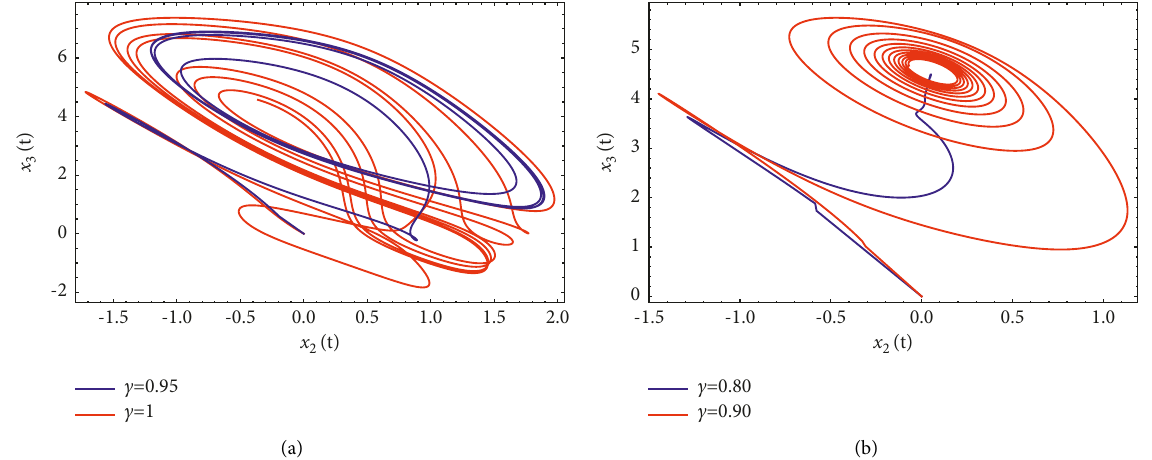
Figure 3: Dynamics of coexisting multiple attractors’ for gradient β (a) State variables x 2 versus x 3 ; (b) state variables x 2 versus x 3 .